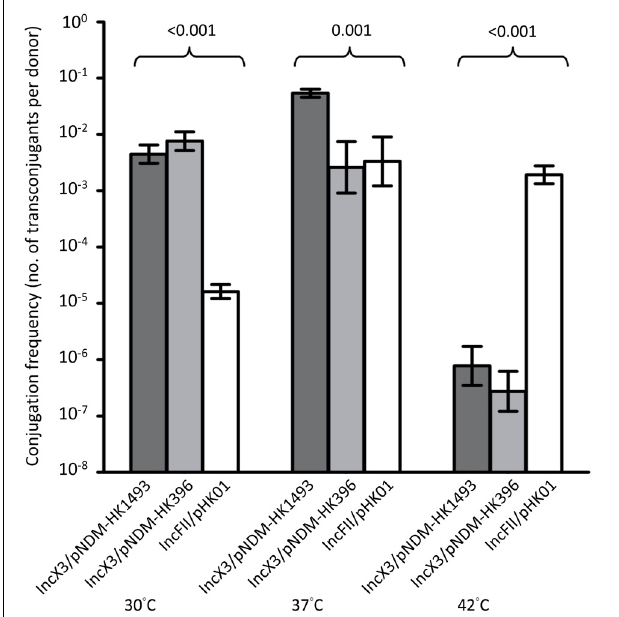
FIGURE 3 | Conjugation frequencies of IncX3 and IncFII plasmids at three temperatures. The donor E. coli strains for the IncX3 plasmids (pNDM-HK1493 and pNDM-HK396) were CRE1493 and CRE396, respectively, while for the IncFII plasmid (pHK01) was combat2D2. The histograms show means and standard deviations (error bars). Conjugation frequencies were logarithmically transformed prior to statistical